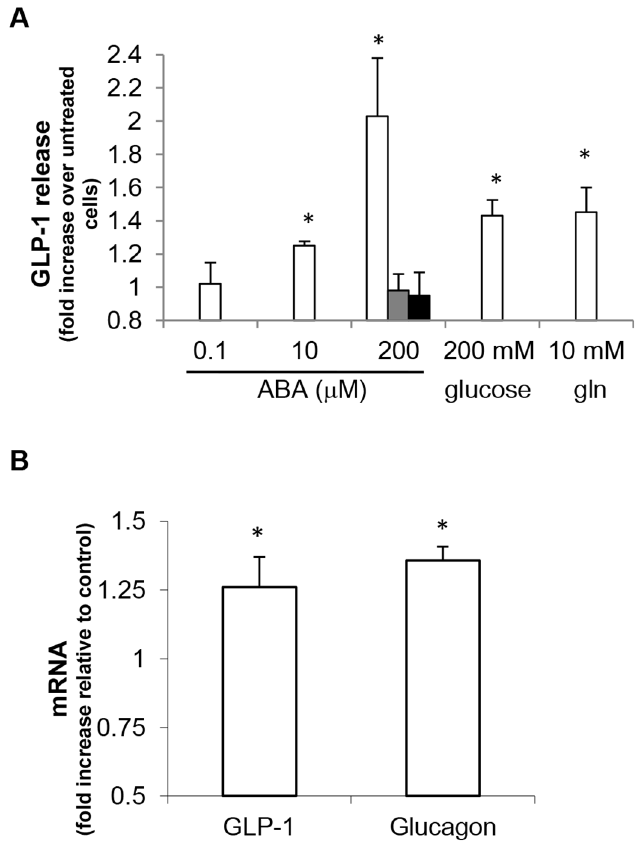
Fig 1. ABA induces GLP-1 release and transcription in hNCI-H716 cells. (A) hNCI-H716 cells were incubated for 2 h in the absence or presence of ABA (at the indicated concentrations), or of 200 mM